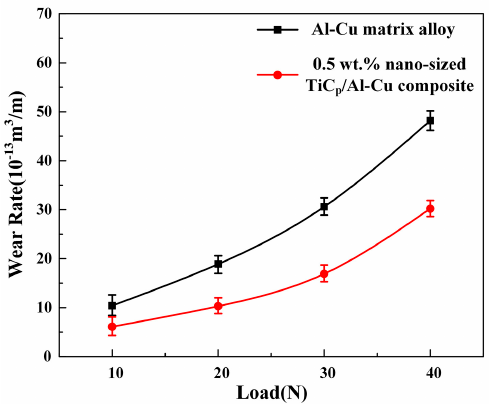
Figure 6. The wear rates of the Al-Cu matrix alloy and 0.5 wt.% nano-sized TiC p /Al-Cu composite under different loads at 180 °C.